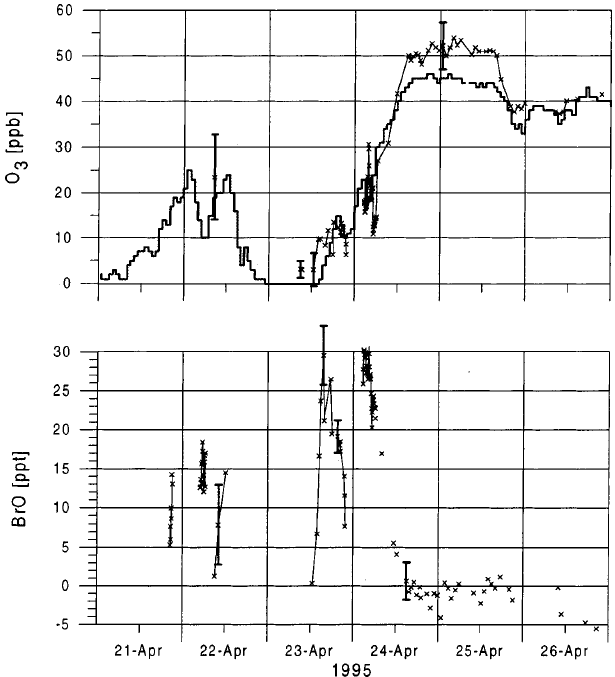
Fig. 3. ARCTOC 1995: mixing ratios of O 3 at Zeppelin Station (Monitor Lab, solid line ), and of O 3 and BrO measured by DOAS ( crosses ) during a low